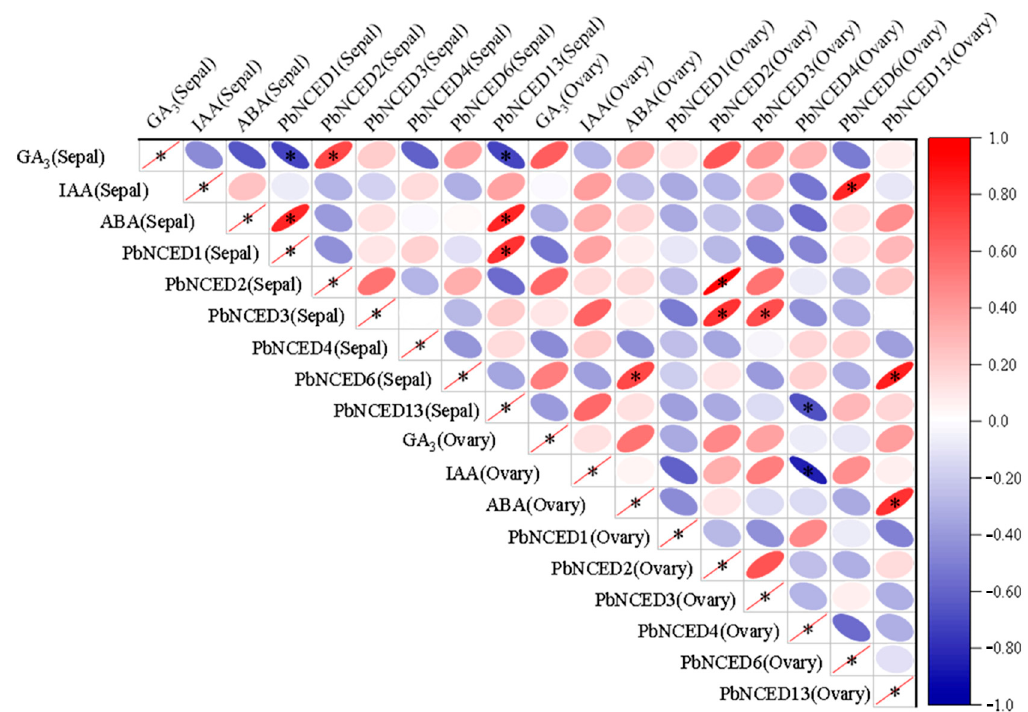
Figure 9. Correlation analysis for biosynthesis gene, content of GA3, IAA, and ABA in ‘Kuerle Xiangli’ during sepal and ovary development. Different asterisk indicated significant differences between groups (* p < 0.05).